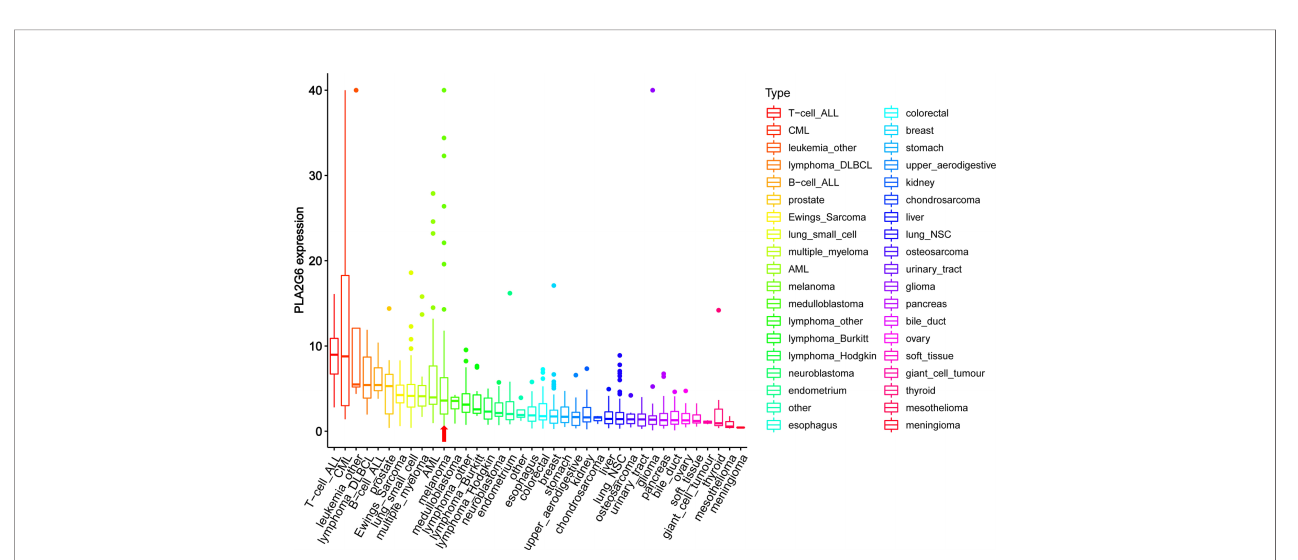
FIGURE 1 | PLA2G6 expression was elevated in cutaneous melanoma. (A) The expression fi le of Oncomine showed different mRNA levels of PLA2G6 in normal nevi samples (n = 18) and melanoma samples (n = 45). (B) Immunohistochemistry staining for PLA2G6 in clinical melanoma tissue and nevus tissue (the large panel was at a 100× magni fi cation and the small panel was at a 400× magni fi cation). (C) The immunostaining scores of melanoma tissues (n = 52) and nevus tissues (n = 27) were displayed using t test. (D) The mRNA level and (E) protein level of PLA2G6 in normal human epidermal melanocytes (MC) and four typical melanoma cell lines M14, SK-MEL-28, A375, and A875. (F) The mRNA level of PLA2G6 was detected by RT-qPCR between melanoma tissues (n = 9) and adjacent non-tumor tissues (n = 9). * P < 0.05, ** P < 0.01, *** P < 0.001, **** P < 0.0001.